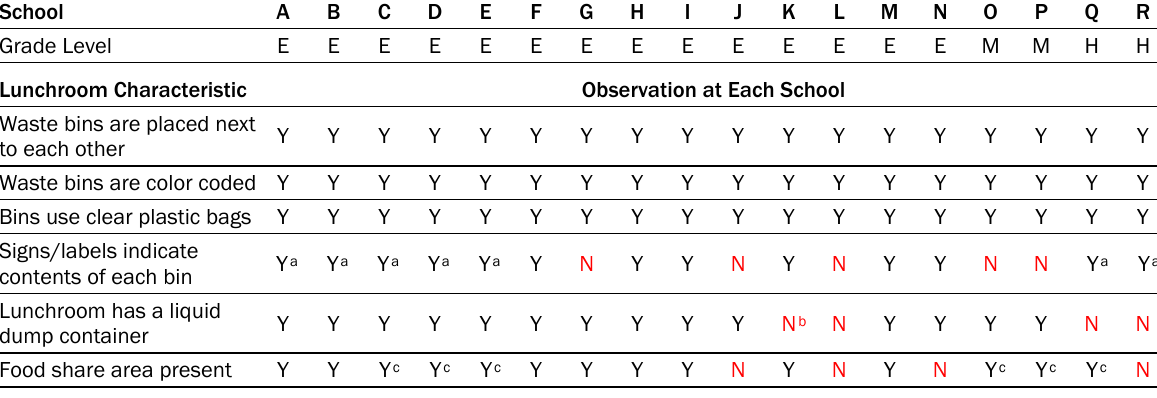
Table 2. Lunchroom-specific Observational Data Recorded During Waste Audits